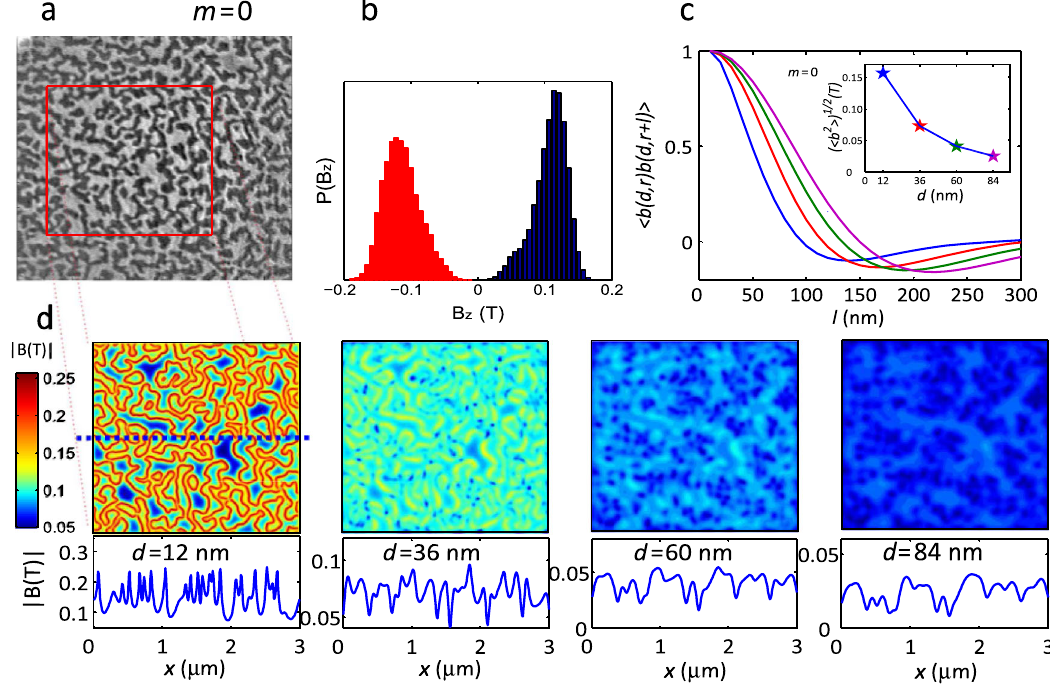
FIG. 1. Fringe fields from the magnetic electrode. (a) X-ray microscopy image of the magnetic electrode at the coercive field (corresponding to m ¼ 0 ). The signal is due to the dichroic absorption of circularly polarized x rays at the L 3 Co absorption edge incident normal to the film surface. The image is 5 (cid:1) 5 (cid:1) m 2 . The fringe fields were calculated from these images using OOMMF code , calculated from (a) at a distance of 12 nm from the magnetic [26]. (b) Distribution of perpendicular magnetic fringe fields, B z electrode. (c) Normalized in-plane correlation function of the fringe fields at different distances from the electrode, 12 nm blue, 36 nm red, 60 nm green, and 84 nm purple. The inset shows the rms value for the fringe field vs distance from the electrode. (d) Magnitude of the fringe field in a 3 (cid:1) 3 - (cid:1) m 2 area is plotted using a color scale at four different distances from the electrode. The lower panels of (d) correspond to the fringe field as a function of position at y ¼ 1 : 5 (cid:1) m , a profile through the center of the corresponding color